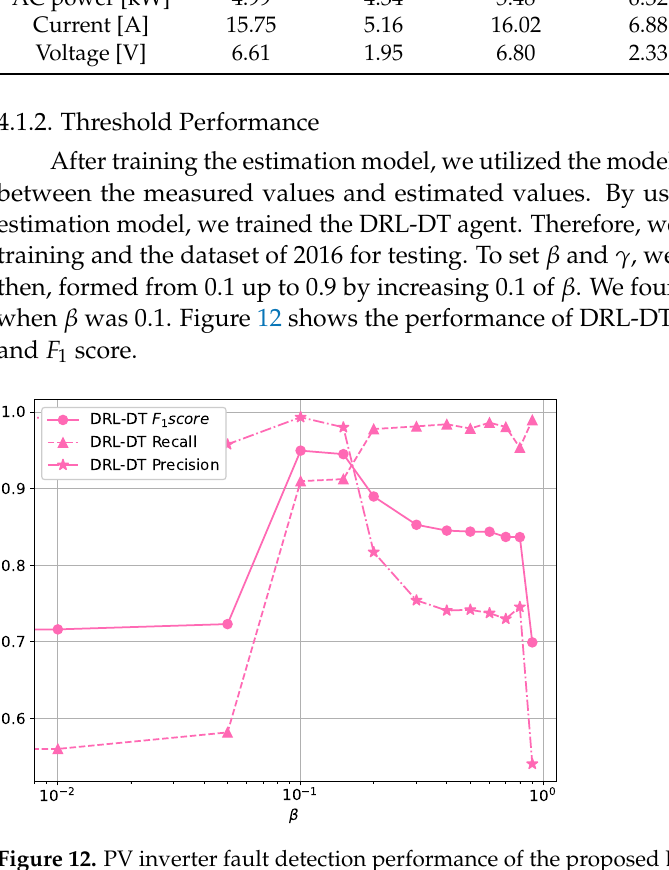
Figure 12. PV inverter fault detection performance of the proposed DRL-DT as a function of β